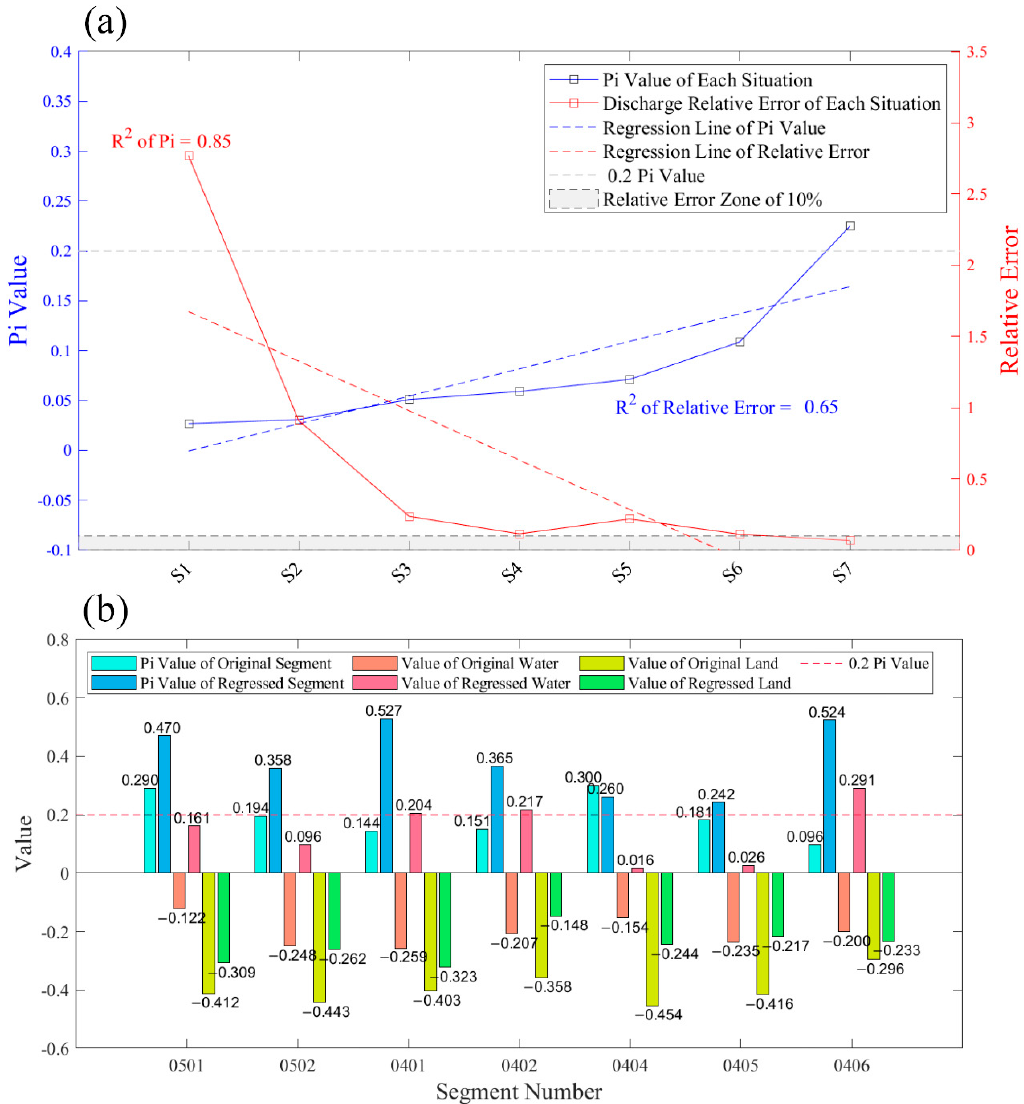
Figure 5. ( a ) Change diagram of flow relative errors and water clarity values, in which the red line represents the water clarity value and the blue line represents the relative error of the flow rate; ( b ) Statistical graph of the water clarity values of each section, in which the light blue column represents the original water clarity value of each section, the dark blue column represents the regressed water clarity value of each section, the orange column represents the original value of water in each section, the red column represents the regressed value of water in each section, the light green column represents the original value of land in each section, the dark green column represents the regressed value of land in each section, and the red dotted line represents the dividing line where the water clarity value is